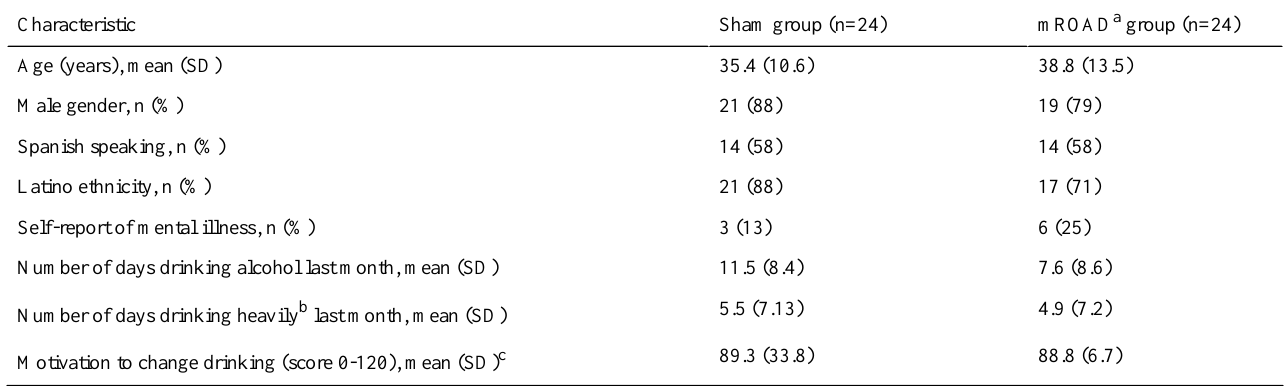
Table 1. Baseline characteristics of the study participants (N=48).